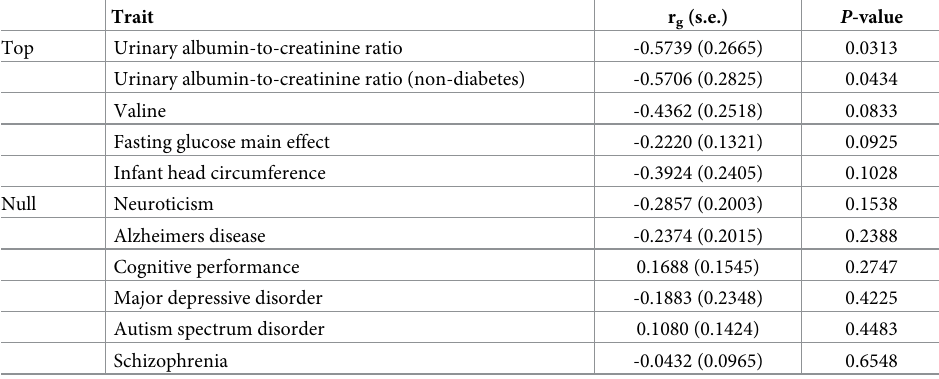
Table 2. Genetic correlation estimates for SHB and selected traits.